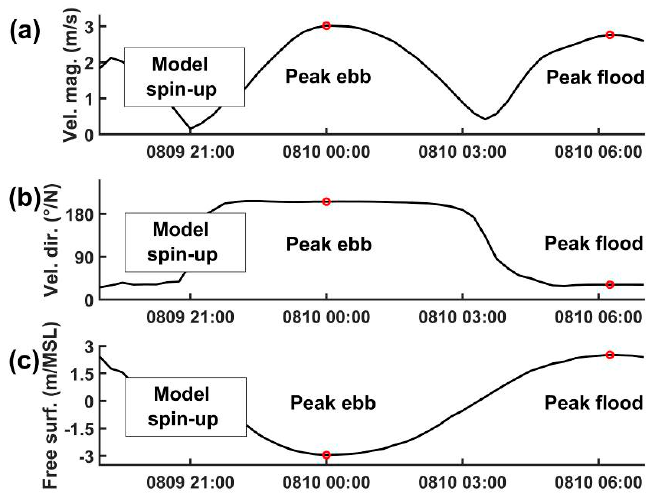
Figure 2. Time-series of ( a ) depth-averaged velocity magnitude, ( b ) depth-averaged velocity direction, and ( c ) free surface elevation extracted from the Telemac3D model (simulation without turbine) in the center of the fence (49°42.300 ′ N; 2°6.180 ′ W). The red circles show times of peak ebb and flood retained to assess the array efficiency.